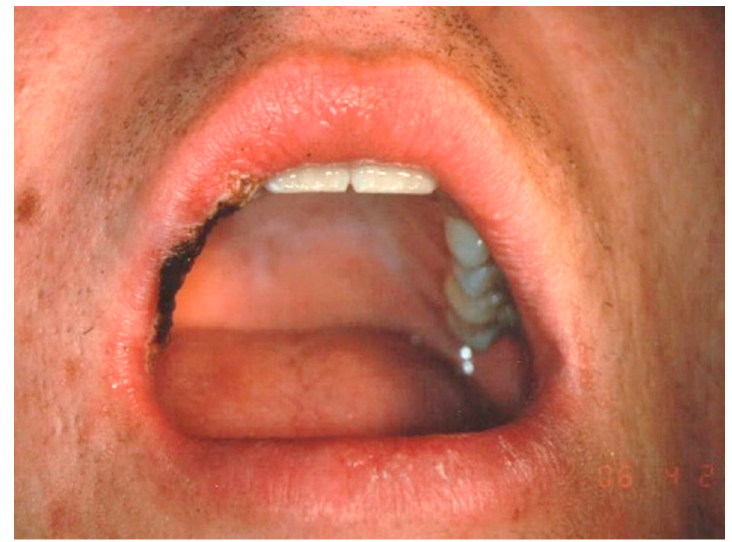
Figure 6. The mucosal layer covering the blood cittern was vaporized and removed in focused mode using the CO 2 laser.